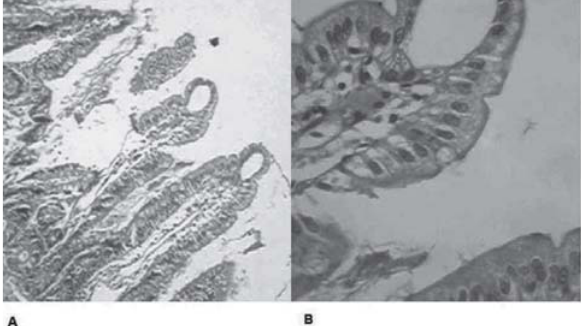
Fig. 3 - Fotomicrografia do grau 1 da classificação de Chiu et al. [6] (HE, A x 100, B x 400) - rato 2 do grupo C